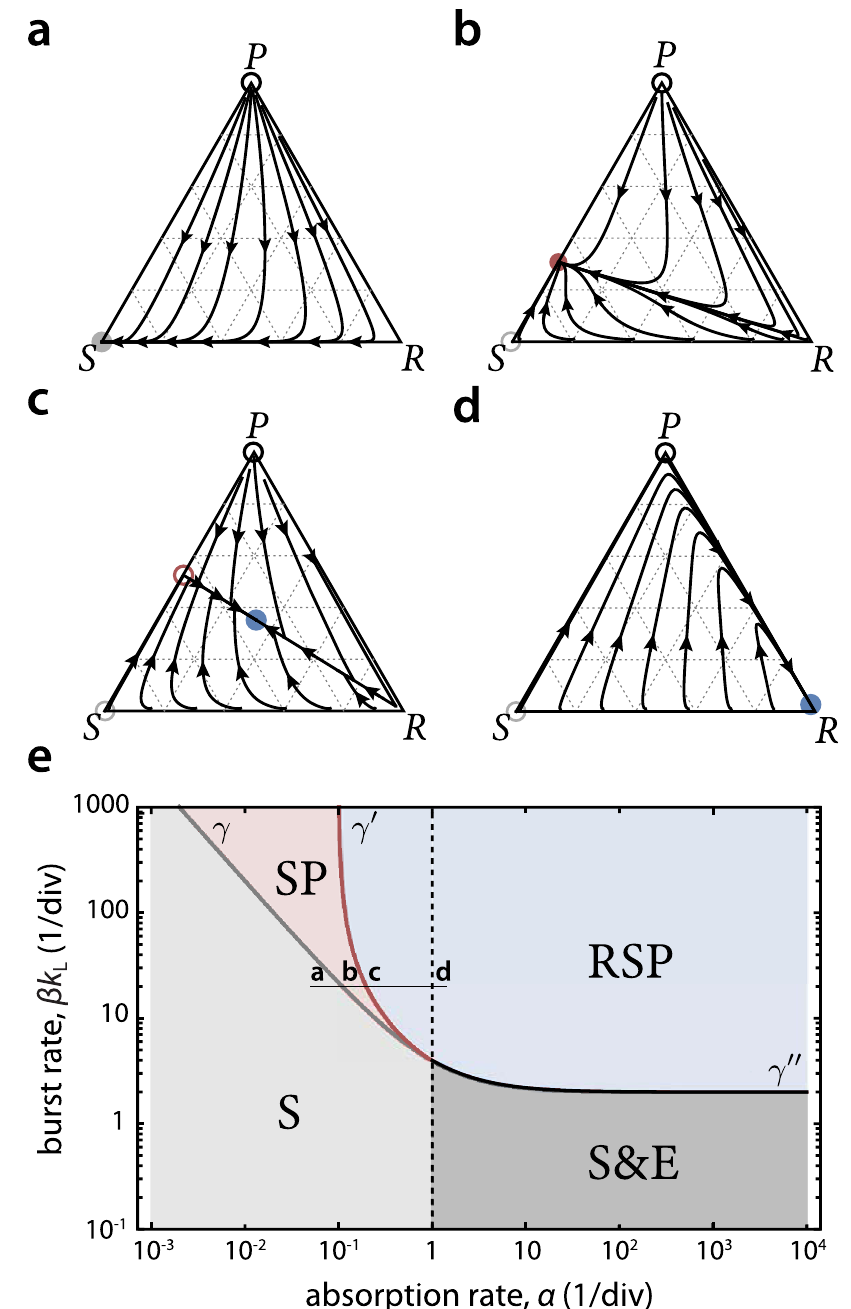
Fig. 2 Stable phases for preventative defenses. ( a – d ) Flow diagrams of Eq. (3), plotting frequencies of the resistant ( R ) phenotype along the bottom edge, sensitive ( S ) phenotype along the left edge and phage and infected (as P + I ) along the right edge in a ternary plot. Empty ( fi lled) circles - unstable (stable) fi xed points. Color of the fi xed point matches the phase displayed in the phase diagram below. Host extinction at the top corner is represented with a black empty circle. ( e ) Phase diagram for preventative defenses. The S phase (gray region) carries only the S phenotype, the SP phase (pink region) carries the S phenotype and phage, the RSP phase (blue region) carries all phenotypes and phage, the S&E phase (dark gray region) corresponds to bistability between phase S or host extinction E. The curves γ (gray), γ 0 (dark red) and γ ″ (black) denote locations of bifurcations. Letters a-d indicate the locations corresponding to the fl ow diagrams above. Rates are expressed in units of per cell division time (1/div), with d = 1, b = 0.9, k L = 1 and s = 10 − 4 . Results are shown for high phage-receptor binding af fi nity ( K m → 0) and minimal sensitivity ( n r = 1). See Methods, `Stability analysis at low binding af fi nity' for K m > 0 and Supplementary Figs. 7 – 9 for dependence on n r , b and k L